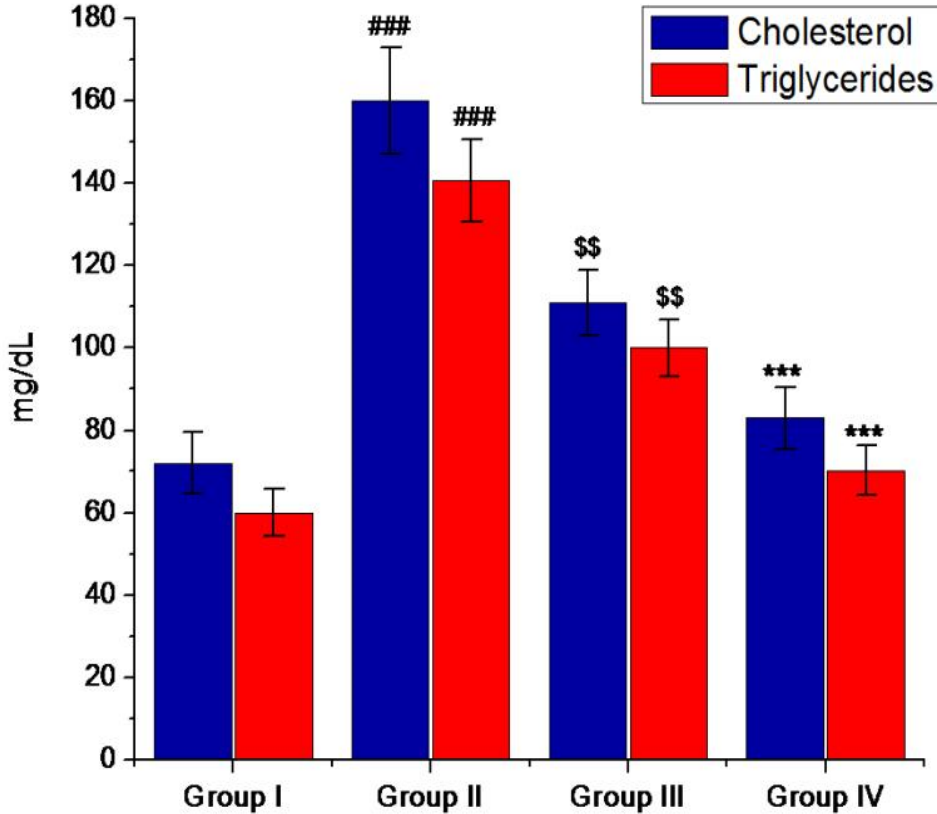
Figure 9. Levels of lipids (mg/dl) of various study groups. Group-I; normal control, Group-II; diabetic left untreated, Group-III; diabetic treated with glibenclamide, Group-IV; diabetic treated with mino/AgNPs. ‘#’ indicates a significant difference between the control and diabetic groups; ‘$’ indicates a significant difference between the diabetic and glibenclamide treatment groups; ‘*’ indicates a significant difference between the diabetic and mino/AgNPs treatment groups. Each bar represents the value of mean ± SD of eight replicates. Statistical icons: $$ = p ≤ 0.01; ###, *** = p ≤ 0.001.